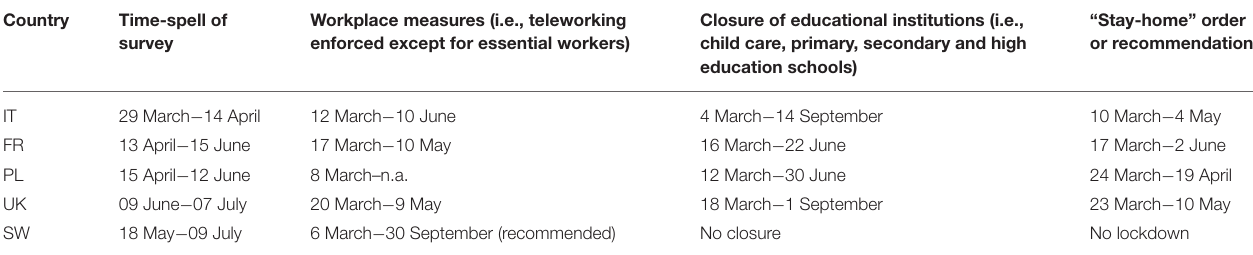
TABLE 1 | Time line of social distancing measures and survey by country. Country Time-spell of Workplace measures (i.e., teleworking survey enforced except for essential